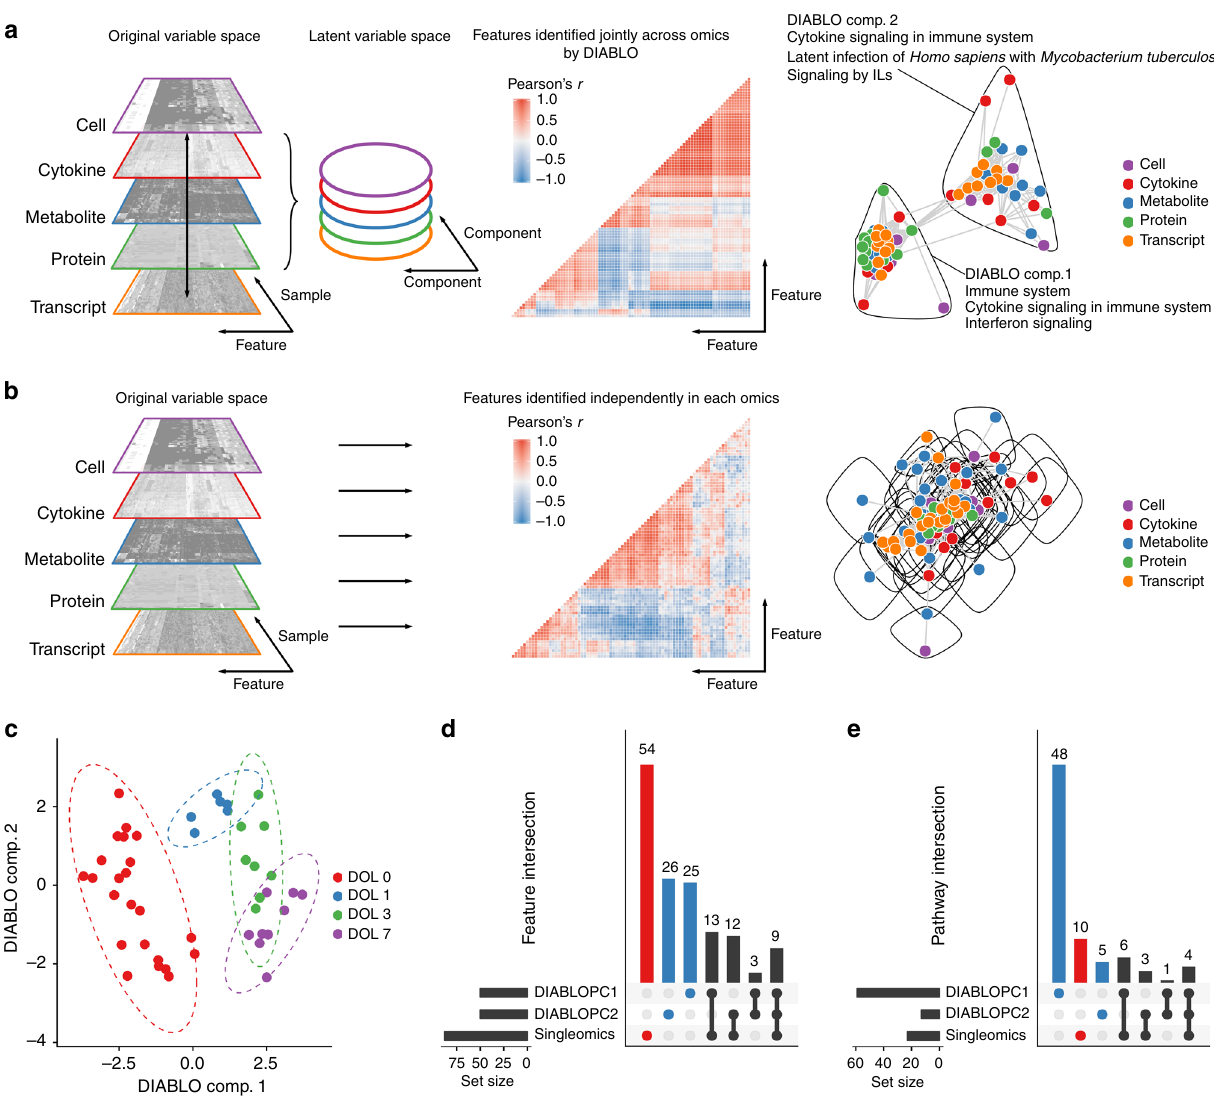
Fig. 5 DIABLO uncovered biologically relevant features by integrating information across data types. Schematic representation of two contrasting integration approaches using multivariate techniques: a shows that DIABLO selects features jointly across data types, resulting in the identi fi cation of features with strong associations across data types. Conversely, as shown in b , ensembles of multivariate models, constructed independently of each other, result in a selection of features that are poorly associated across data types. This is visualized in correlation heatmaps of the selected features and corresponding networks, with dense subgraphs, or network modules, encircled. In particular, the network modules identi fi ed in ( a ) include a number of features selected from all data types. This is not the case in b . The minimal set of features selected by DIABLO across data types as shown in c could discriminate between DOL and distinct sets of these features separated DOL0 from all other DOLs (DIABLO component 1) and DOL1, 3, and 7 from each other (DIABLO component 2). Features identi fi ed by DIABLO (blue bars) were largely distinct from those identi fi ed by more traditional single-OMICs multivariate approaches (red bars; overlaps in gray); shown in d using an UpSet plot. Moreover, features identi fi ed by DIABLO were more strongly enriched for known biological (functional) pathways; shown in e using an UpSet plot (blue vs. red bars). Horizontal bars are mapped to the number of elements in each set of features being compared. Vertical bars correspond to the number of elements in the intersections when carrying out various set comparisons. DIABLO: Data Integration Analysis for Biomarker discovery using Latent cOmponents, DOL: day of interactions (Supplementary Figure 8), implying functional was processed according to the same methods as described above interconnections. This validation con fi rmed that our meta- (Fig. 1 and Supplementary Figure 9). The outputs for the PNG integration approach identi fi ed functionally important biological data demonstrated the same basic trajectory as a function of DOL interactions central to neonatal ontogeny. and showed considerable overlap (e.g. in transcriptomics p < 10 – 138 for the Jaccard index/similarity for DOL3 vs. DOL0 and DOL7 vs. DOL0 in the two cohorts). Overall, integrative multi- variate modeling using DIABLO predicted the correct DOL well for these independent cohorts (Fig. 6, Supplementary Figure 10). To quantify the predictive performance of this model, we used the area under the receiver operator characteristics curve (AUROC). born cohort (30 participants) from a different region of the world (Papua New Guinea (PNG), Australasia). This validation cohort